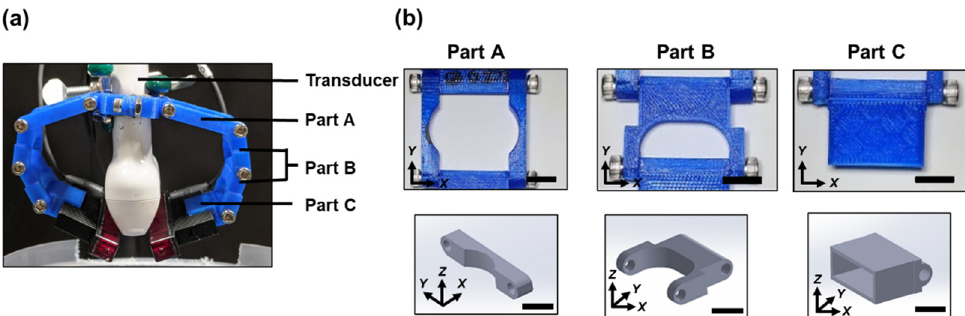
Figure 2. ( a ) Modular hinge system holding the LED arrays and attached to the US transducer. ( b ) The photographs of the individual pieces are shown in the top panel. The 3D renderings of the hinge pieces are shown on the bottom panel. Part A fits around the transducer and extends the horizontal reach of the holder to allow the LEDs to be placed at angles approaching 90 ◦ . Part B in conjunction with Part A allows precise horizontal and vertical height adjustment. The holder consists of two-part B pieces, and schematic of only one piece is shown in the panel. Part C holds the LEDs using the heat sinks and provides flexibility for any final adjustments on the LED illumination angle. Scale bar = 10